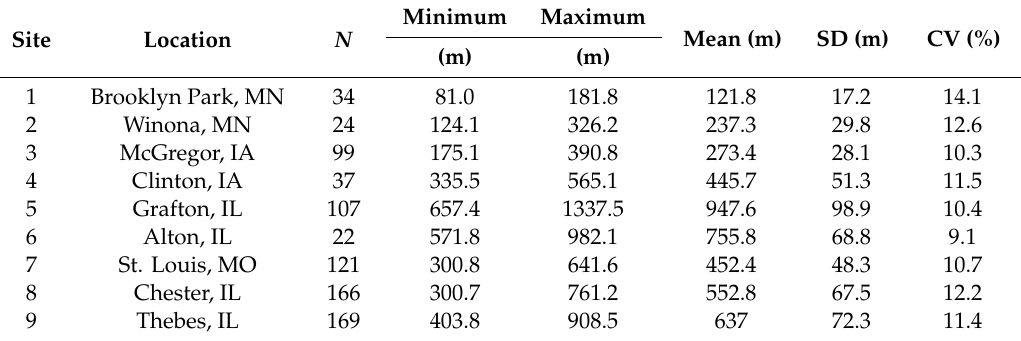
Table 3. Statistics of river widths obtained from Landsat imagery for the nine study